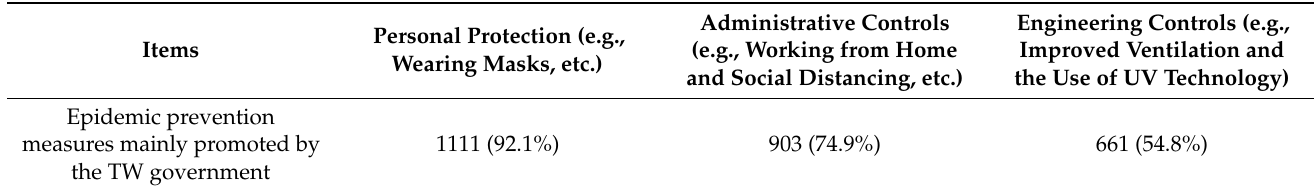
Table 6. The cognition of official epidemic prevention measures (multiple responses).